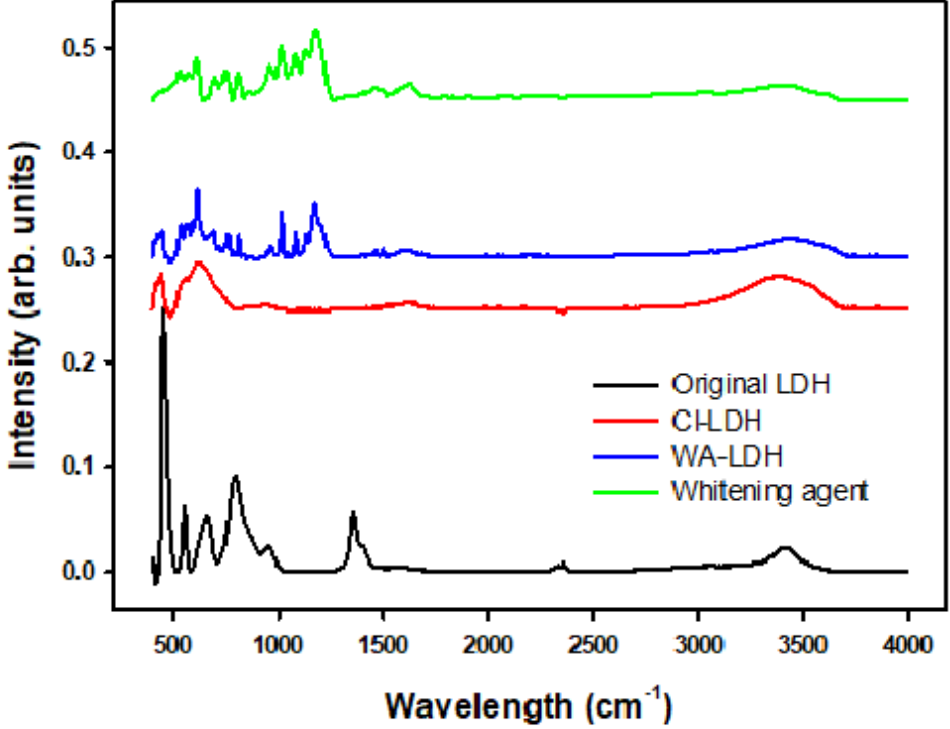
Figure 1. FT-IR spectra of the unmodified LDH, Cl-LDH, WA-LDH, and the whitening agent.